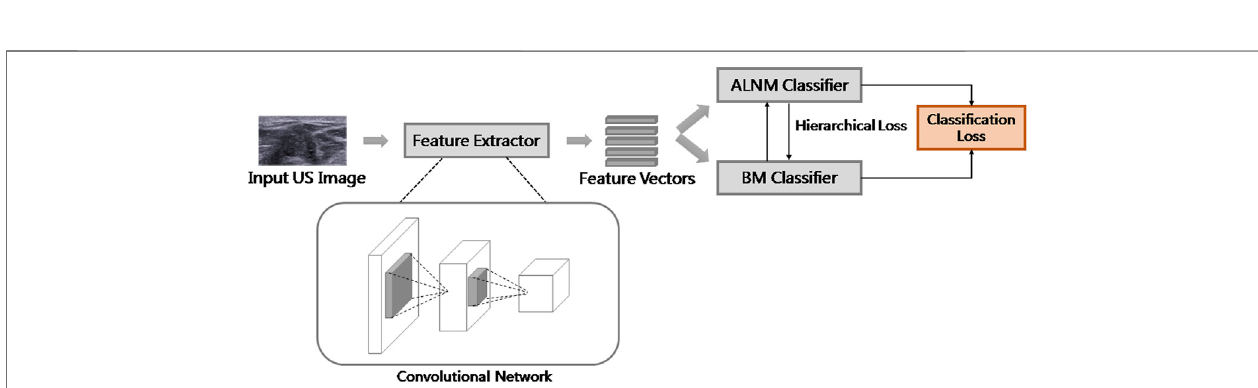
FIGURE1| Flowchart oftheprocedures inthe developmentand evaluation ofourdeep-learning modeland radiomics model formalignancyprediction and ALNM prediction.